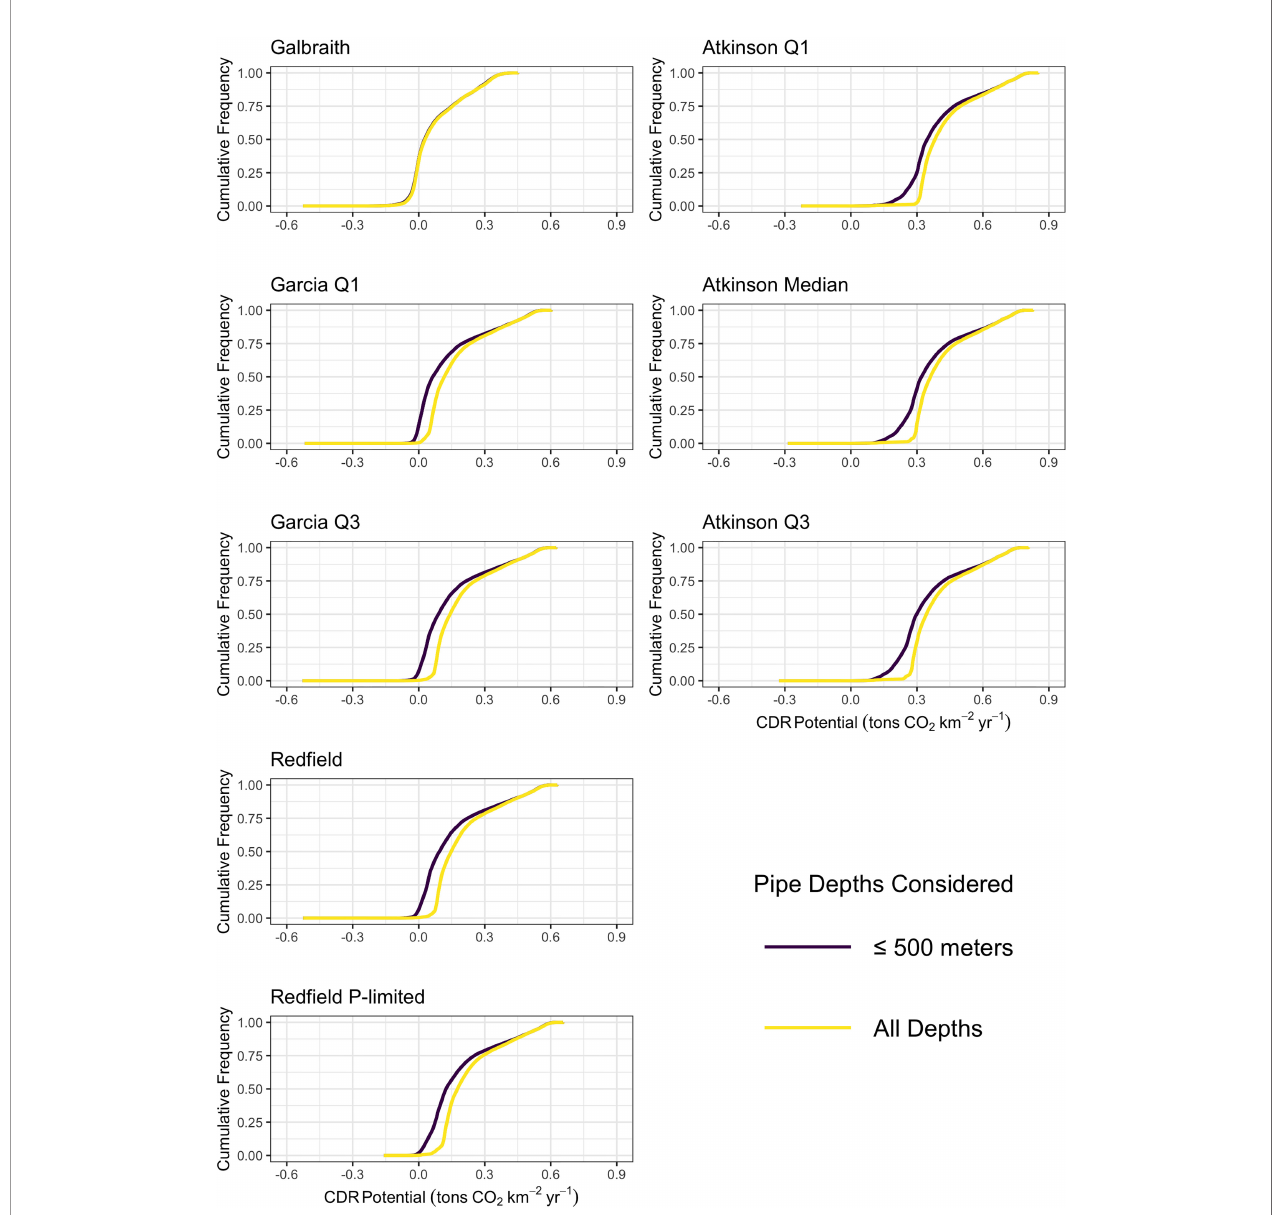
FIGURE 3 | Empirical cumulative distribution functions of the maximum potential carbon dioxide removal for all microalgae (left column) and macroalgae (right column) stoichiometries with the constraint of an upwelling pipe no longer than 500 meters (dark purple) and without limits to the depth of the upwelling pipe